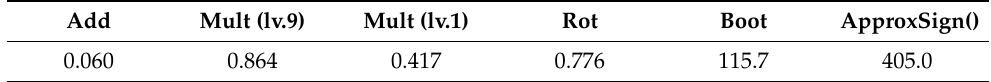
Table 2. Average Time (ms) of CKKS unit operations and subroutines.